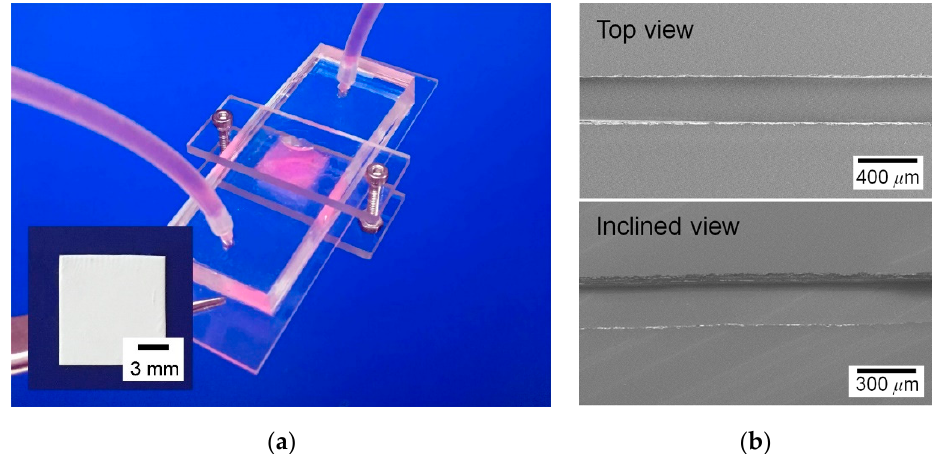
Figure 4. Microfluidic chip with a nanofiber scaffold ( a ) and SEM images of the microchannel of the chip ( b ).